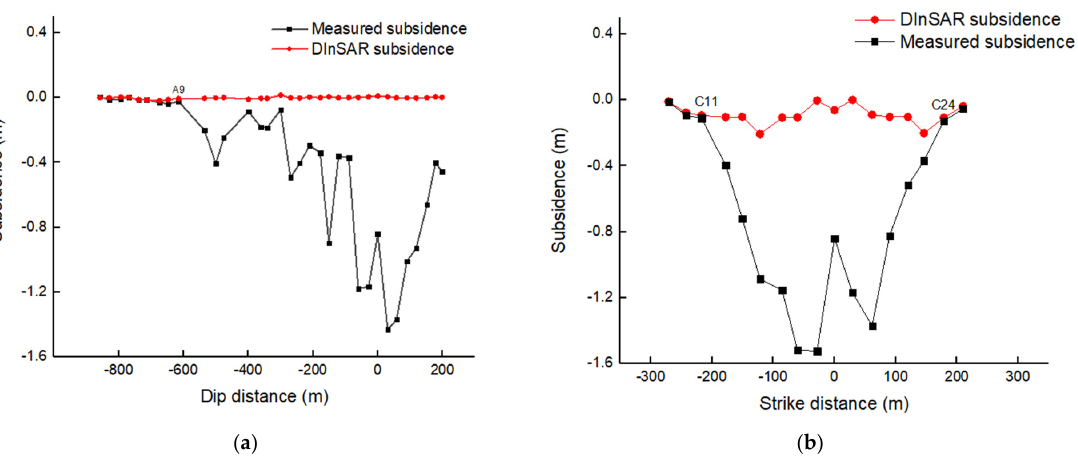
Figure 4. Comparison between the DInSAR monitoring and leveling data along line A ( a ) and line C ( b